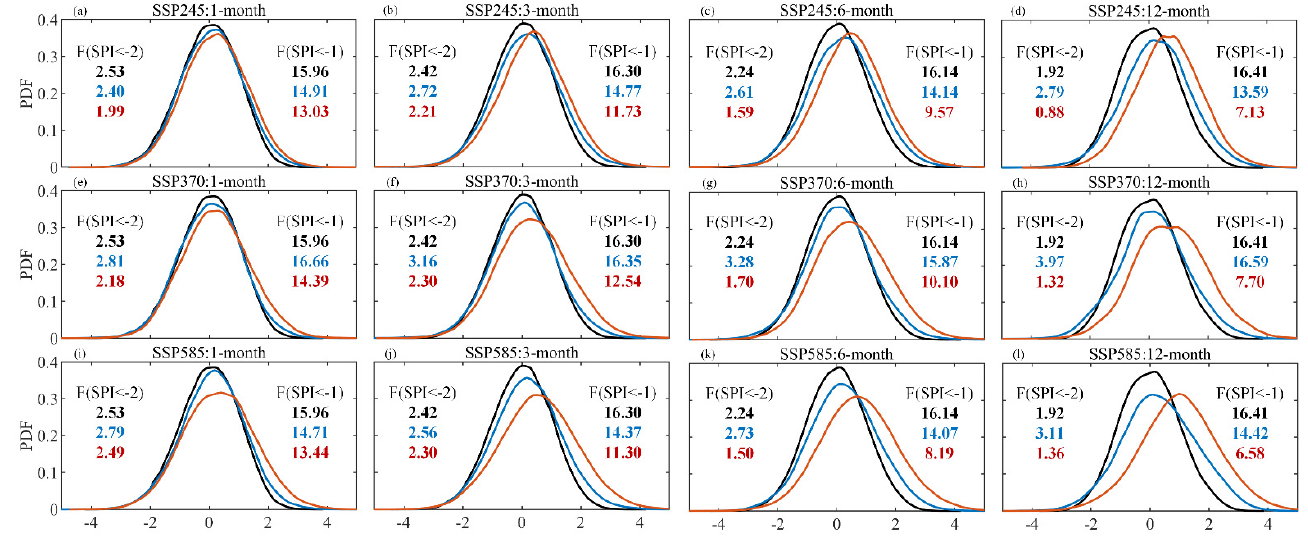
Figure 8. Probability distributions of 1-month ( a , e , i ), 3-month ( b , f , j ), 6-month ( c , g , k ), and 12-month ( d , h , l ) scale SPI under SSP245 ( a – d ), SSP370 ( e – h ), and SSP585 ( i – l ) scenarios. The black, blue, and red lines represent the probability distributions for the historical period (1981–2010), 2030–2059, and 2070–2099, respectively, and the black, blue, and red letters represent the probabilities (%) of SPI < − 2 and SPI < − 1 for the corresponding periods.